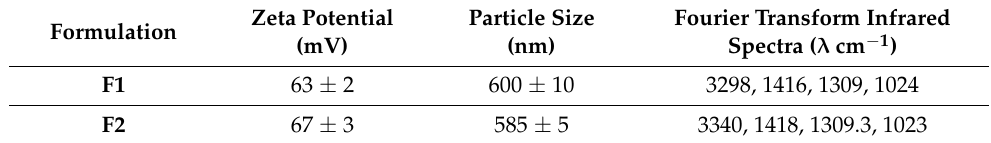
Table 1. Zeta potential, particle size analysis, and Fourier transform infrared. N = 3, mean ± SD.